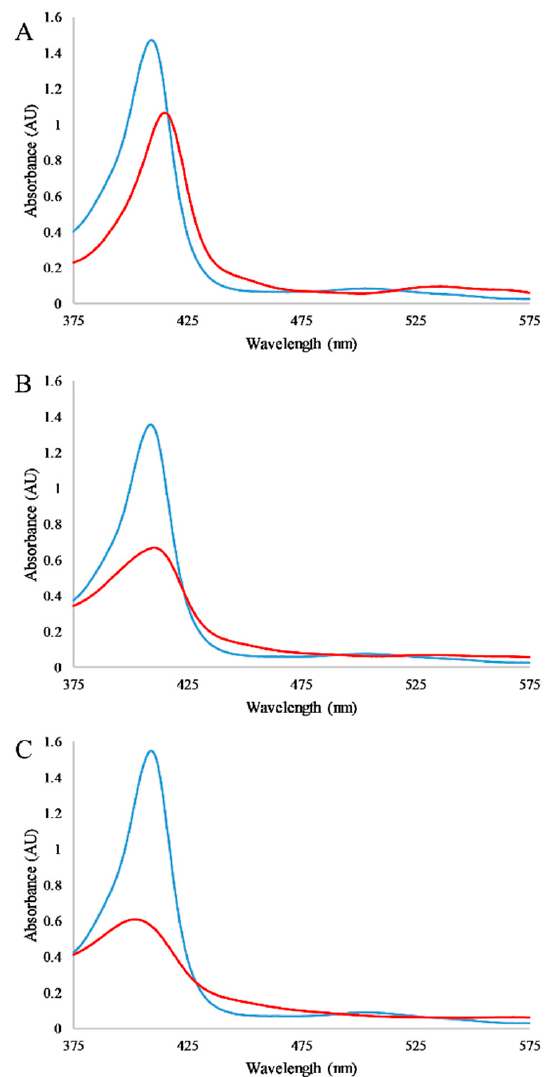
Figure 2. Absorbance spectra of myoglobin and detergents. Spectra of 0.2 mg / mL myoglobin in the absence (blue lines) and presence (red lines) of detergents: ( A ) 1 mM SDS, ( B ) 2 mM EBB, ( C ) 2.5 mM TTAB. All spectra are representative examples after 30 min of incubation with the detergent; samples were in 2 mM phosphate bu ff er at pH